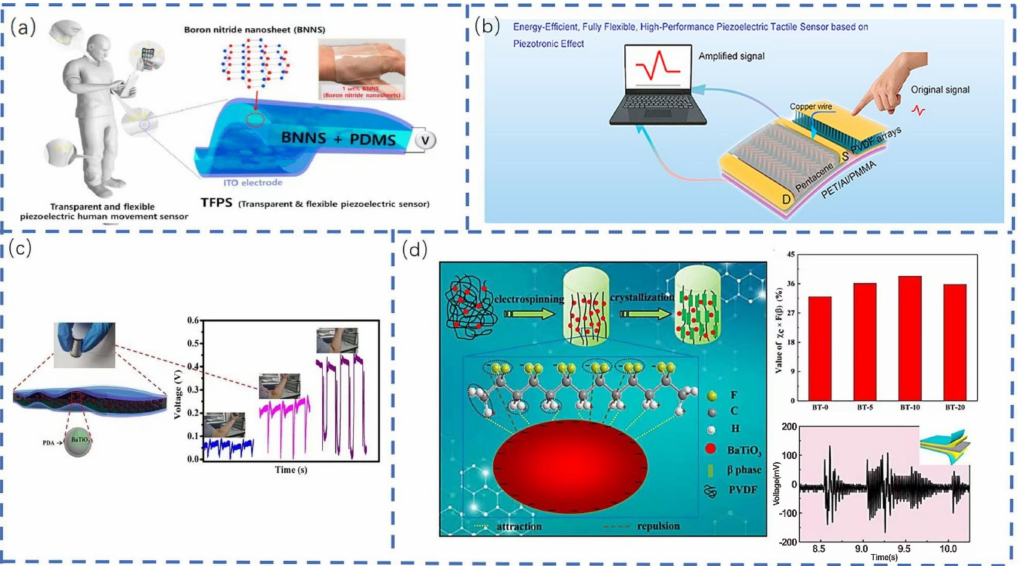
Figure 6. Applications of strain-based flexible sensors in smart wearable sensing: ( a ) a schematic diagram of flexible piezoresistive sensors adapted for human motion, including two layers of ITO electrodes, BNNS/PDMS piezoelectric active layer, and TFPS on the hand device [51]; ( b ) the structure of a high-performance strain-based sensor and a flexible transistor based on the piezoelectric effect, where PET is the flexible substrate and PMMA is the dielectric layer [52]; ( c ) the structure of a high- performance flexible piezoelectric sensor and transistor based on the piezoelectric effect, where PET is the flexible substrate and PMMA is the dielectric layer [53]; and ( d ) the mechanism of electrospinning BaTiO 3 /PVDF composite fibers and the open circuit voltage response to the different sounds of the device vibrating from the speaker